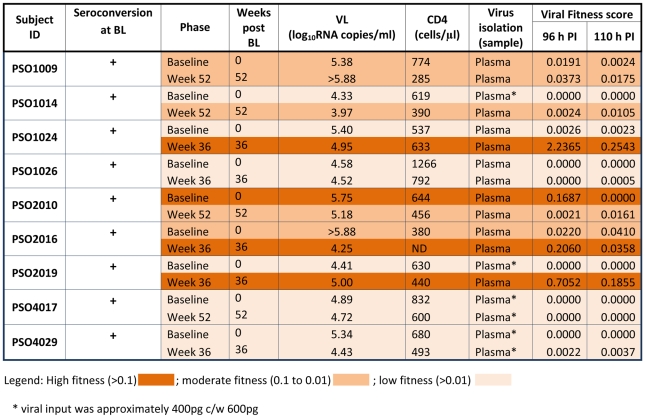
Clinical and experimental data obtained for PHAEDRA subjects.Shown are clinical and experimental data obtained for PHAEDRA subjects from which virus was successfully isolated and subsequently tested using the real time PCR assay. Indicated by the column headings are the subject identification code, seroconversion status at Baseline (‘+’ indicates subject had seroconverted, ‘-’ indicates subject was seronegative), and the phase of the PHAEDRA study at which the relevant sample was collected. The time (in weeks) post Baseline that the sample was collected, coincident VL and CD4+ T cell counts, and the sample type from which virus was successfully isolated are shown. The viral fitness scores calculated using DNA production measured at 96 h post-infection ex vivo, and at the final time-point analysed (110 h post-infection), are shown for each isolate.